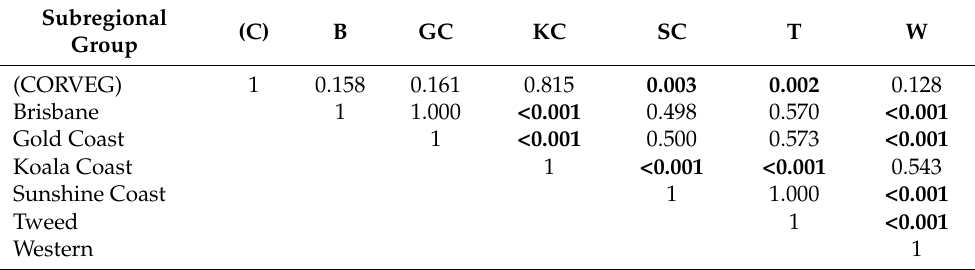
Table 7. Differences in the maximum heights between the CORVEG virtual ALS plots and sub- regional virtual plots; significant p -values (ANOVA with post hoc tests, df = 231, F = 16.065) are shown in bold. The CORVEG plots were significantly different to the Sunshine Coast and Tweed subregional groups, and the Koala Coast and Western groups were significantly different to all the other subregional